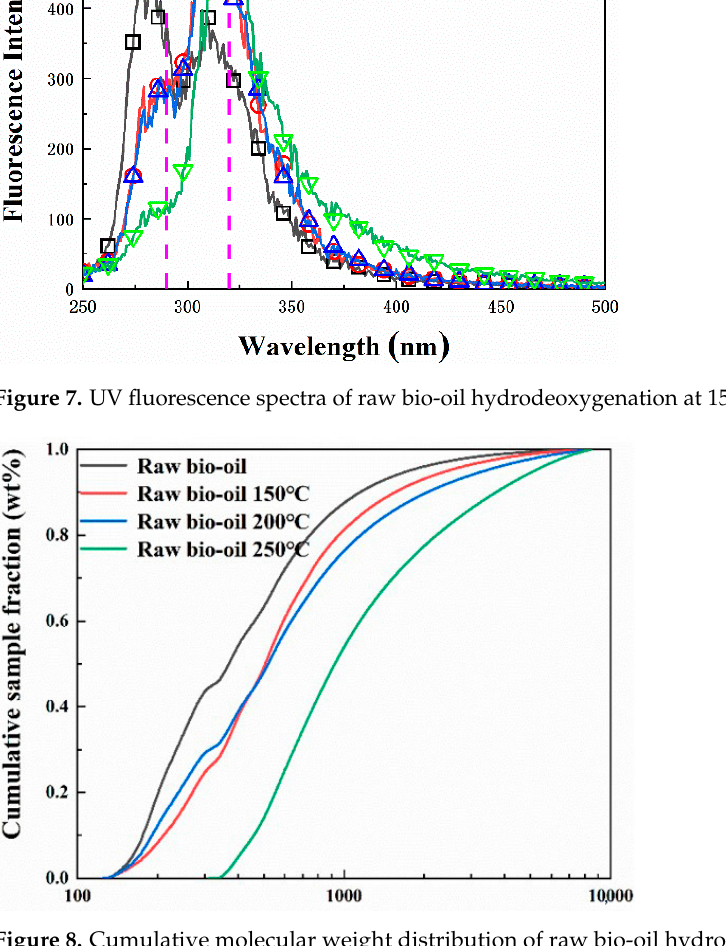
Figure 8. Cumulative molecular weight distribution of raw bio-oil hydrodeoxygenation at 150 °C, 200 °C, and 250 °C.